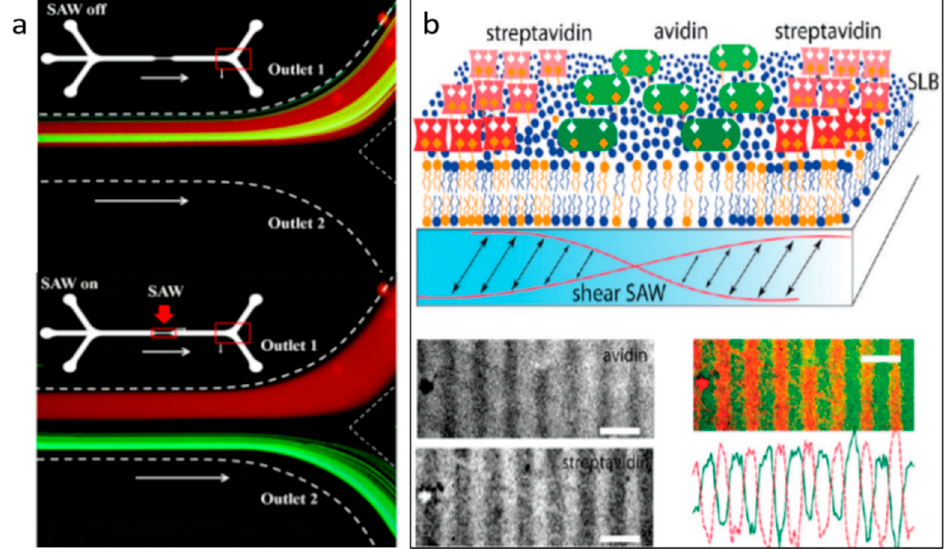
Figure 6. ( a ) When SAW is on, the green fluorescent particles attached to the thrombin are deflected from red fluorescent particles in continuous flow due to the acoustic radiation force. Reprinted with permission from reference [106]. ( b ) Streptavidin and avidin are separated on supported lipid bilayers by SSAW actuation. Reprinted with permission from reference [107]. SLB—supported lipid bilayers.